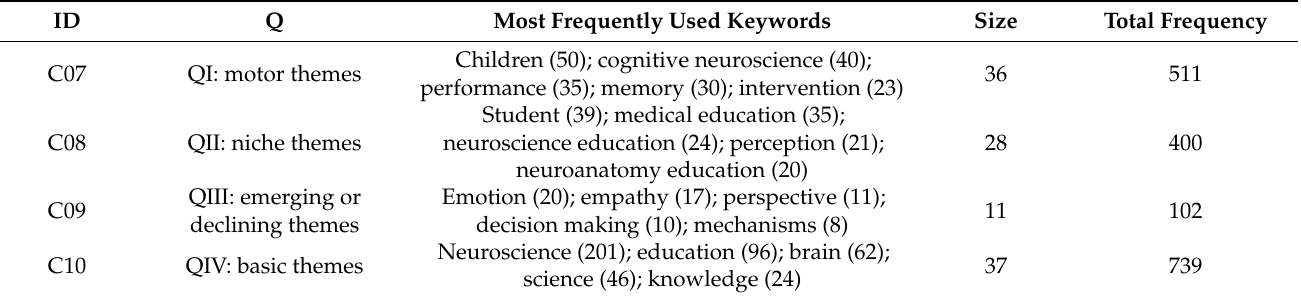
Table 9. Major research themes in neuroscience in the field of education for